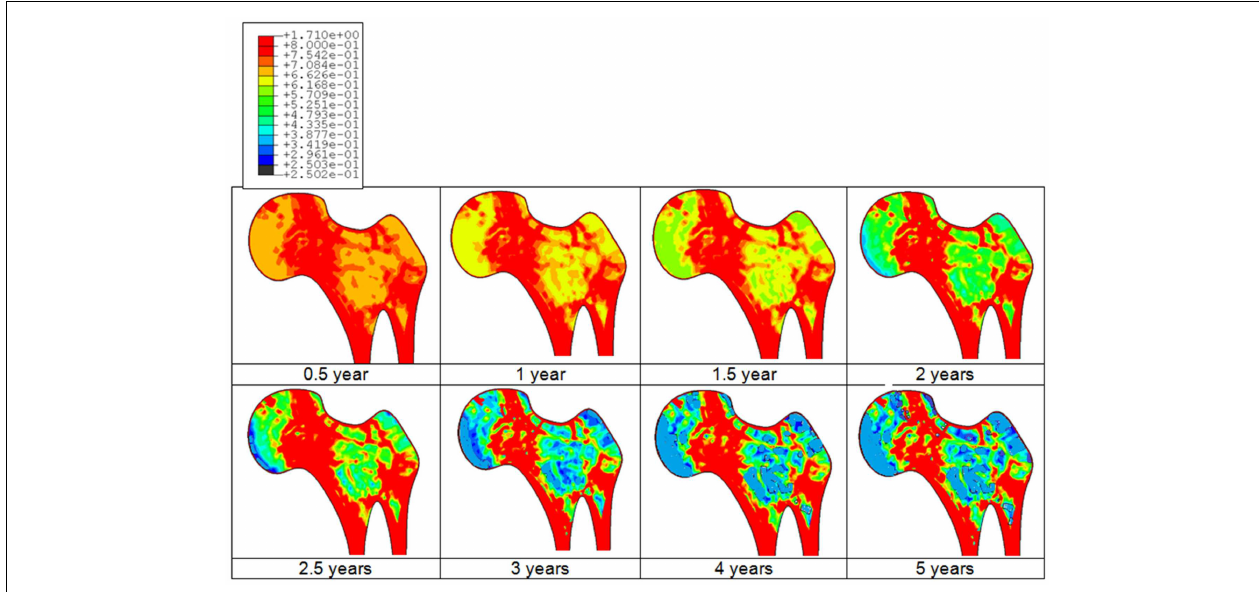
FIGURE 3 | Predicted bone adaptation sequences in the form of apparent bone density variation in gram per cubic centimeter